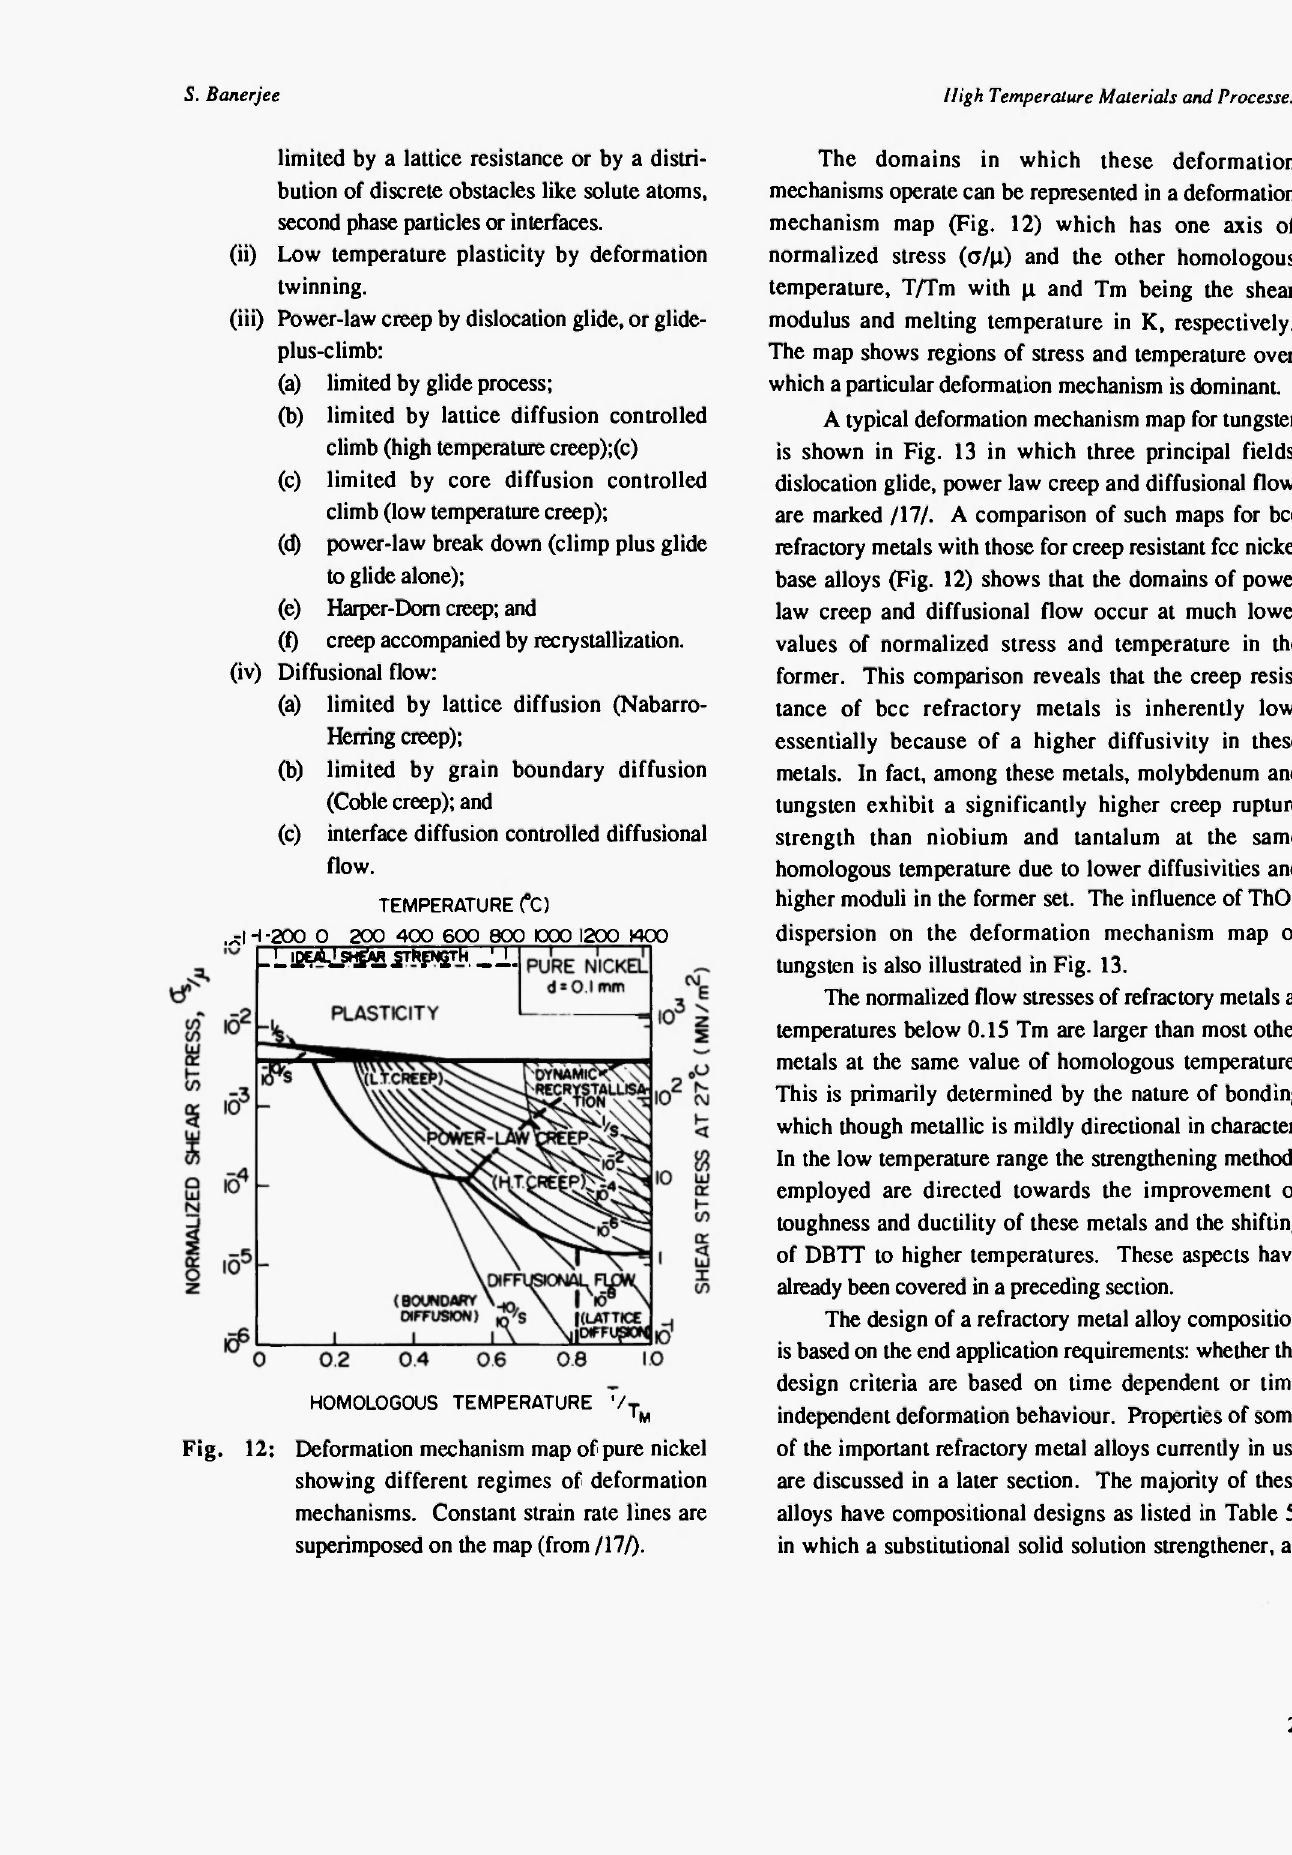
Fig. 12: Deformation mechanism map of pure nickel showing different regimes of deformation mechanisms. Constant strain rate lines are superimposed on the map (from